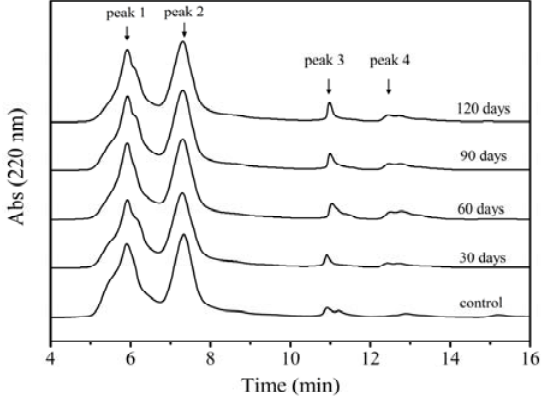
Figure 3. SEC profiles showing changes in gluten protein after frozen storage for different